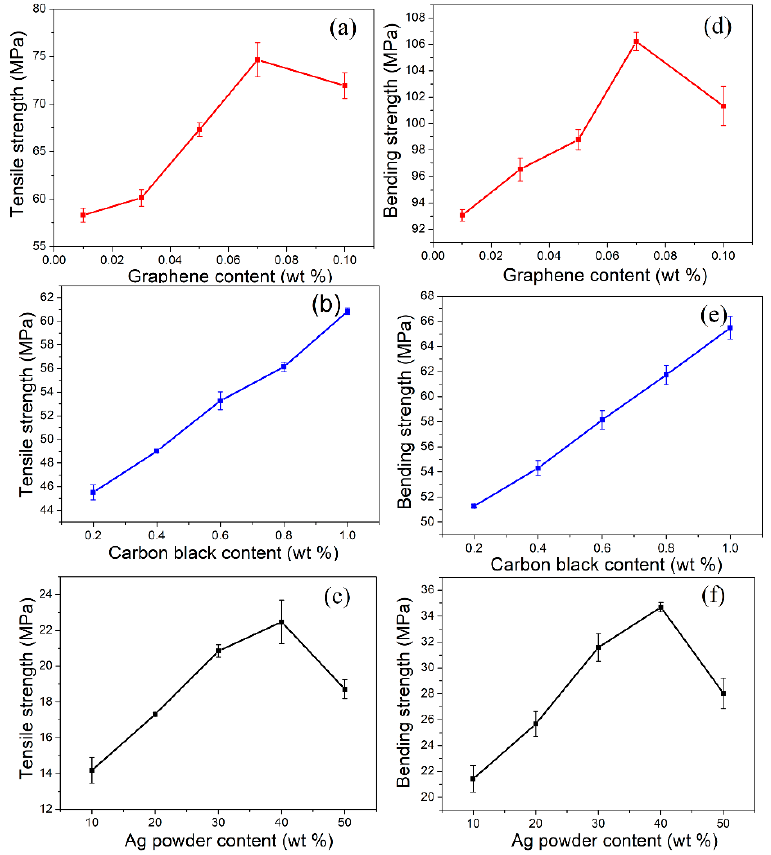
Figure 8. Mechanical properties of the composites: ( a ) the tensile strength of modified GE/EP composites with different contents of modified GE, ( b ) the tensile strength of CB/EP composites with different contents of CB, ( c ) the tensile strength of Ag/EP composites with different contents of Ag particles, ( d ) the bending strength of modified GE/EP composites with different contents of modified GE, ( e ) the bending strength of CB/EP composites with different contents of CB, ( f ) the bending strength of Ag/EP composites with different contents of Ag particles.